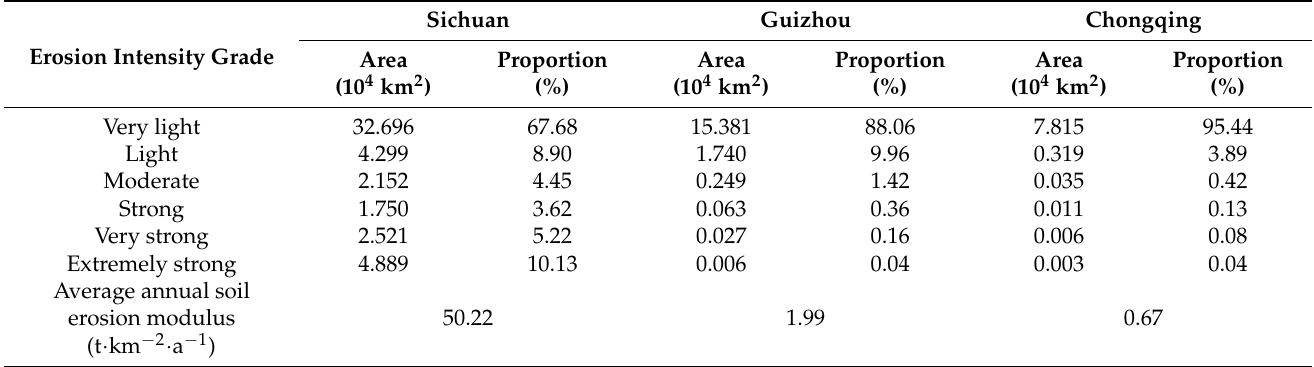
Table 4. Area and proportion of each erosion intensity grade and erosion modulus in three regions.